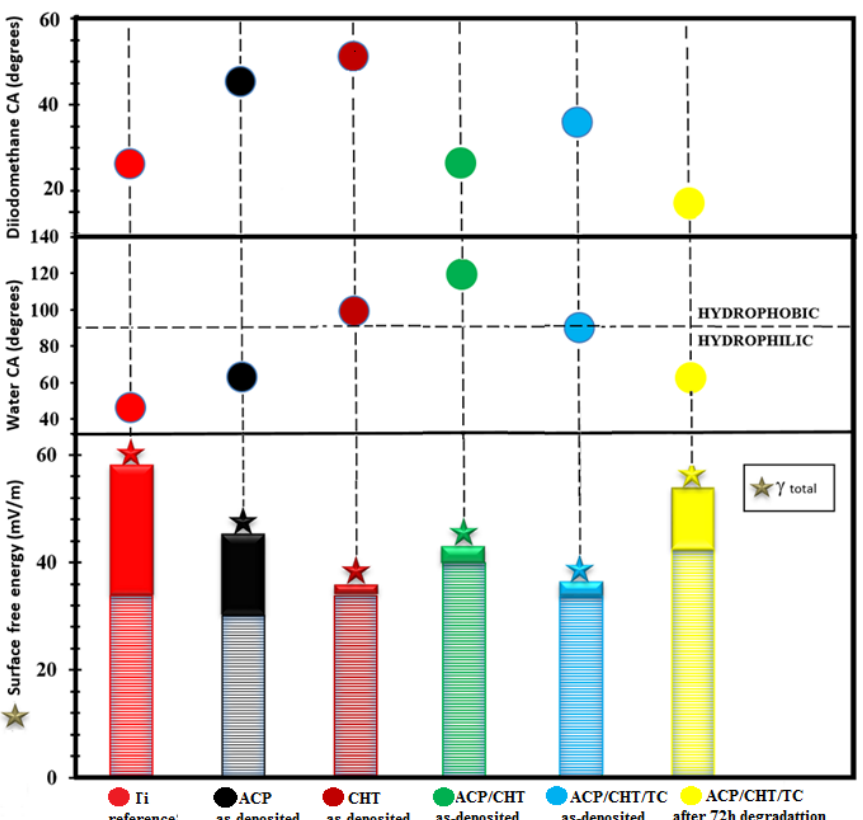
Figure 8. The water and diiodomethane contact angle (CA) and surface free energy (SFE) recorded for the bare Ti substrate and ACP, CHT, ACP/CHT, and ACP/CHT/TC as-deposited coatings vs. ACP/CHT/TC coating after 72 h of degradation in SBF ( γ d—cross-hatched region, γ p—solid region).